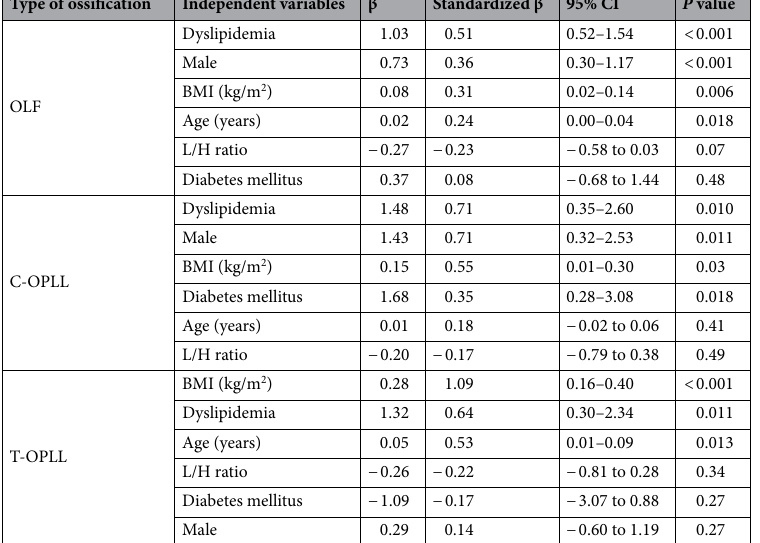
Table 4. Multivariate logistic regression analysis of risk factors for the prevalence of spinal ligament ossification compared to subjects without spinal ligament ossification. β, regression coefficient;CI, confidence interval; OPLL, ossification of the posterior longitudinal ligament; OLF, ossification of the ligamentum flavum; BMI, body mass index; C, cervical; T, thoracic.